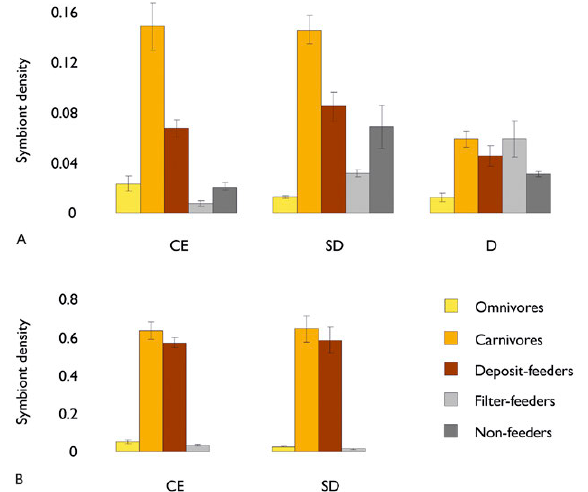
Fig. 9. – Mean density of symbionts (polychaetes and crustaceans) per feeding group for the sponges Agelas oroides (A) and Aplysina aerophoba (B) across the surveyed caves (CE, entrance; SD, semi- dark zone; D, dark zone). Standard error of mean is presented in error